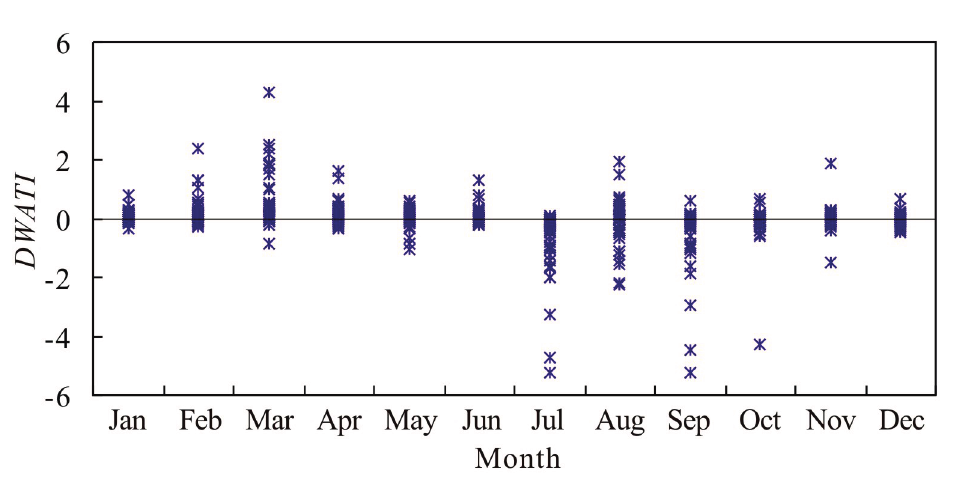
Figure 4. Scatter plot of DWATI in different months during 1960–2010.